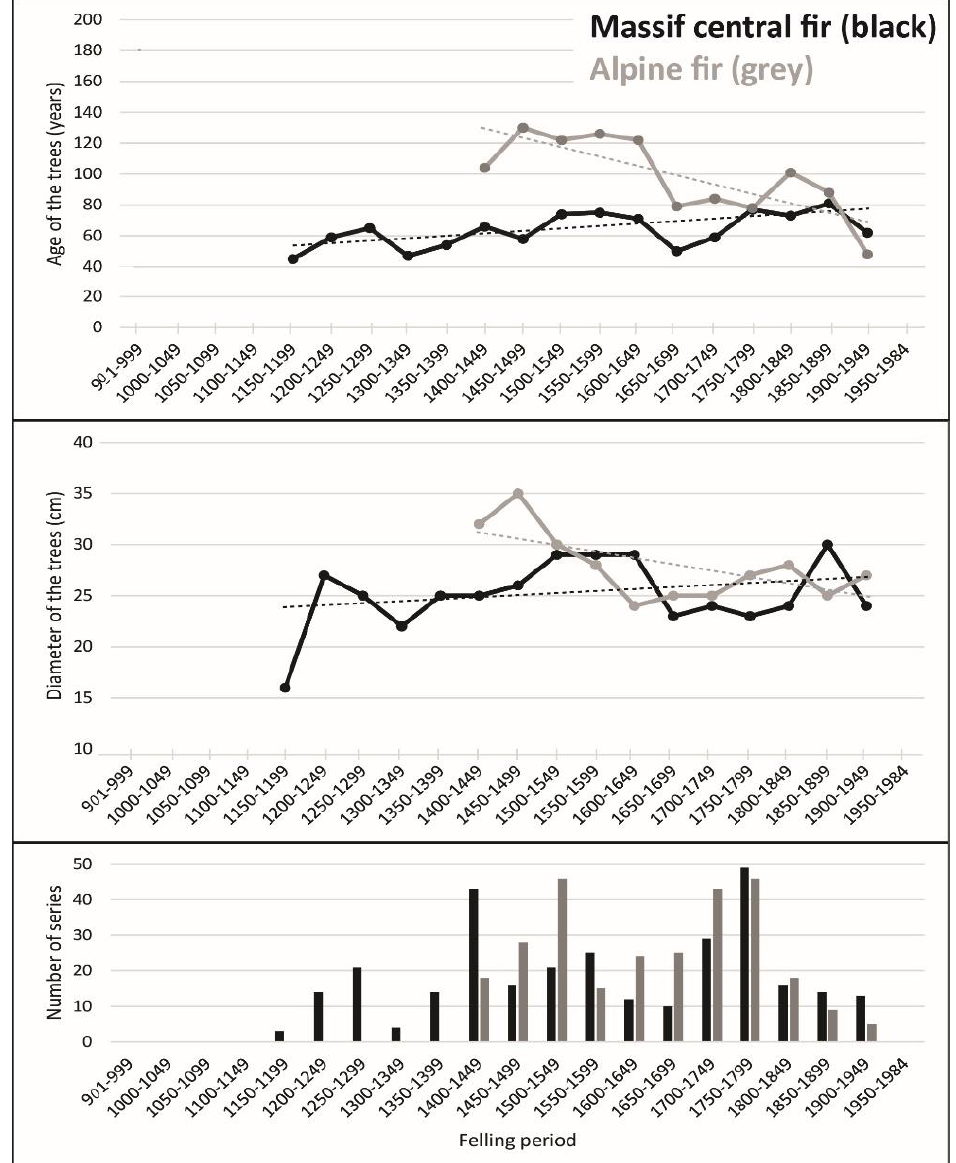
Figure 5. Comparison of the characteristics of archaeological Alpine fir (in grey) and archaeological Massif central fir (in grey) over time. From top to bottom, tree age, tree diameter and number of trees, according to 50-year time windows based on the date of the last ring. In dotted lines, the associated trend curves.